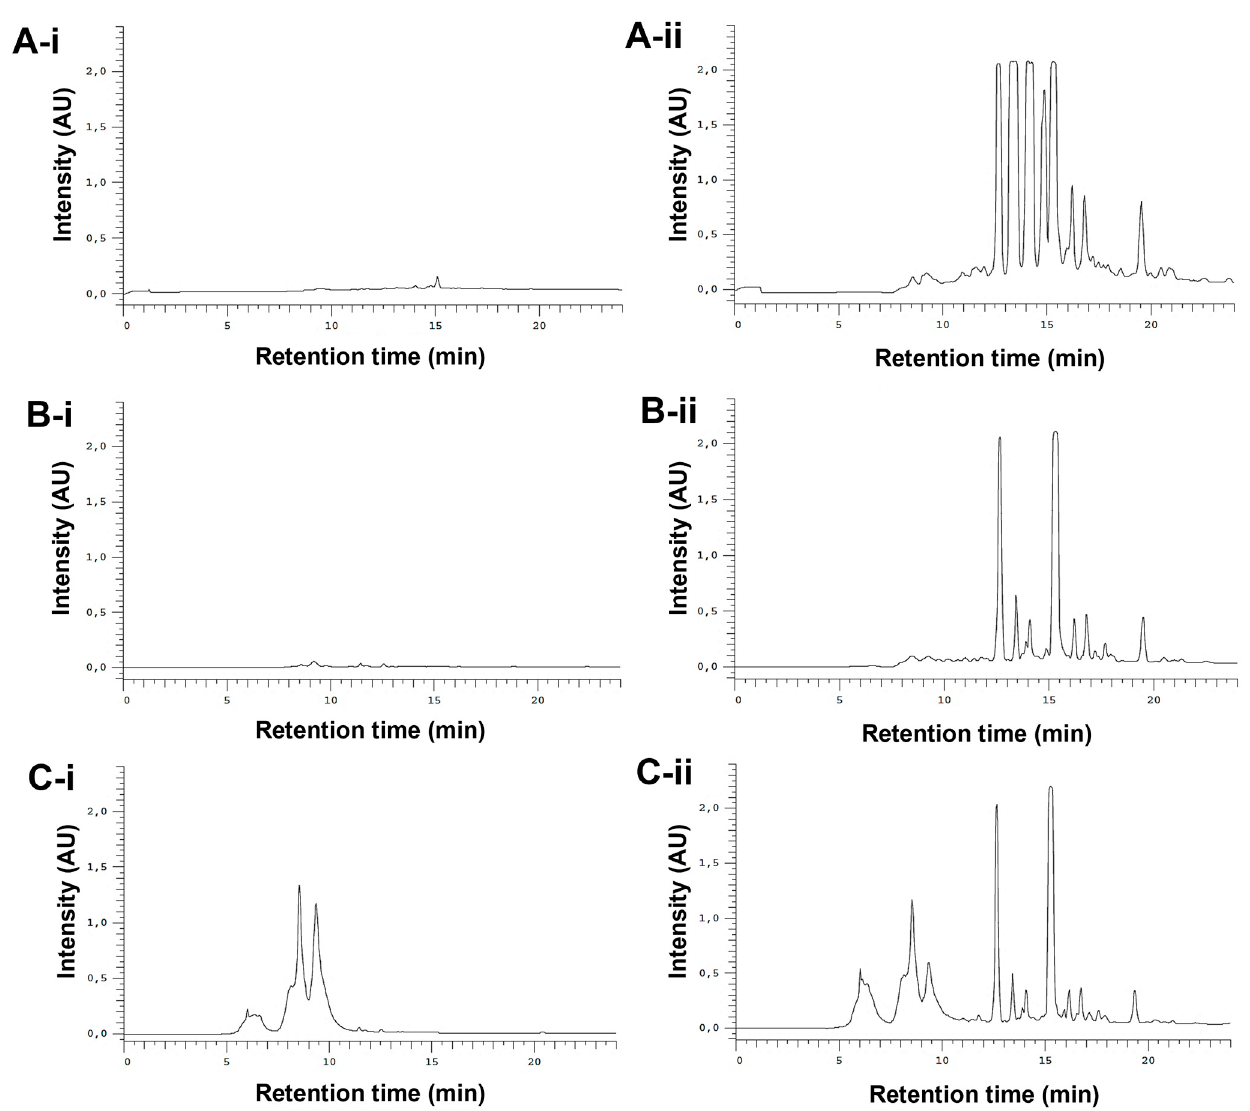
Figure 3. Semi ‐ preparative HPLC chromatograms of DE ‐ R ( A ), DE ‐ F ( B ), and EE ‐ F ( C ) at 19–24.6 μ g/mL (100 μ L), detected at 330 nm (phenols/carboxylic acids; A ‐ i, B ‐ i, and C ‐ i ) and 254 nm (alkyl ‐ amides; A ‐ ii, B ‐ ii, and C ‐ ii